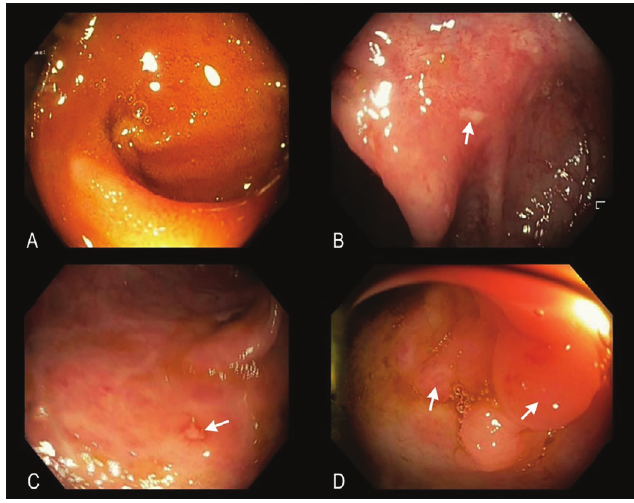
Figure 2 - Endoscopic findings in colonoscopy after infliximab discontinuation. (A) Normal mucosal areas in the terminal ileum, (B, C, D) showing aphthous ulcers in the colon.